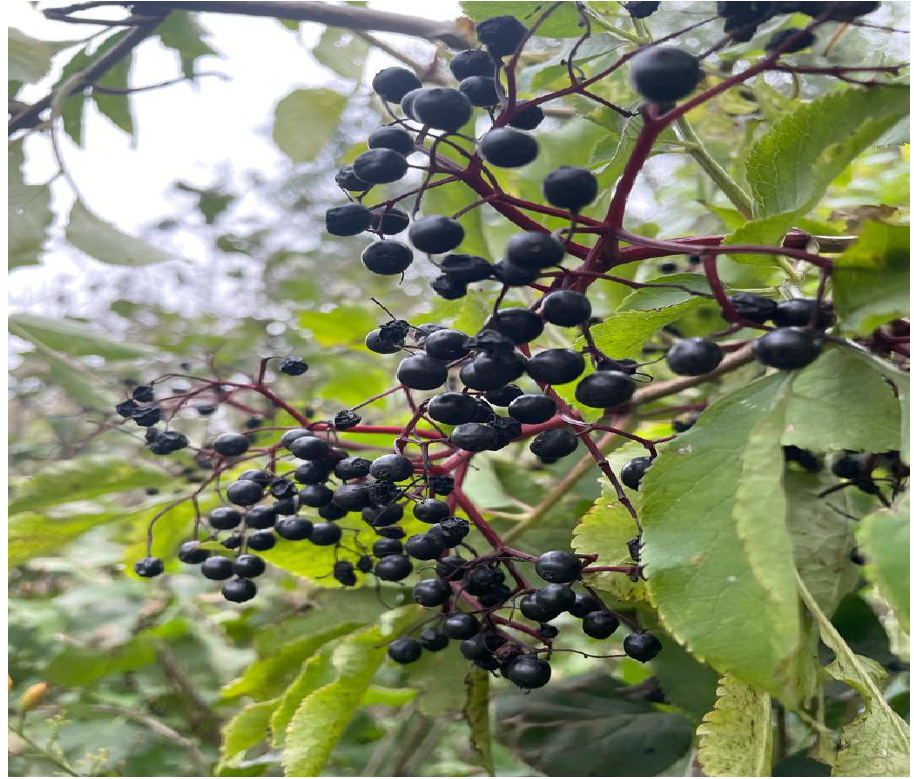
Figure 1. Elderberries found wildly